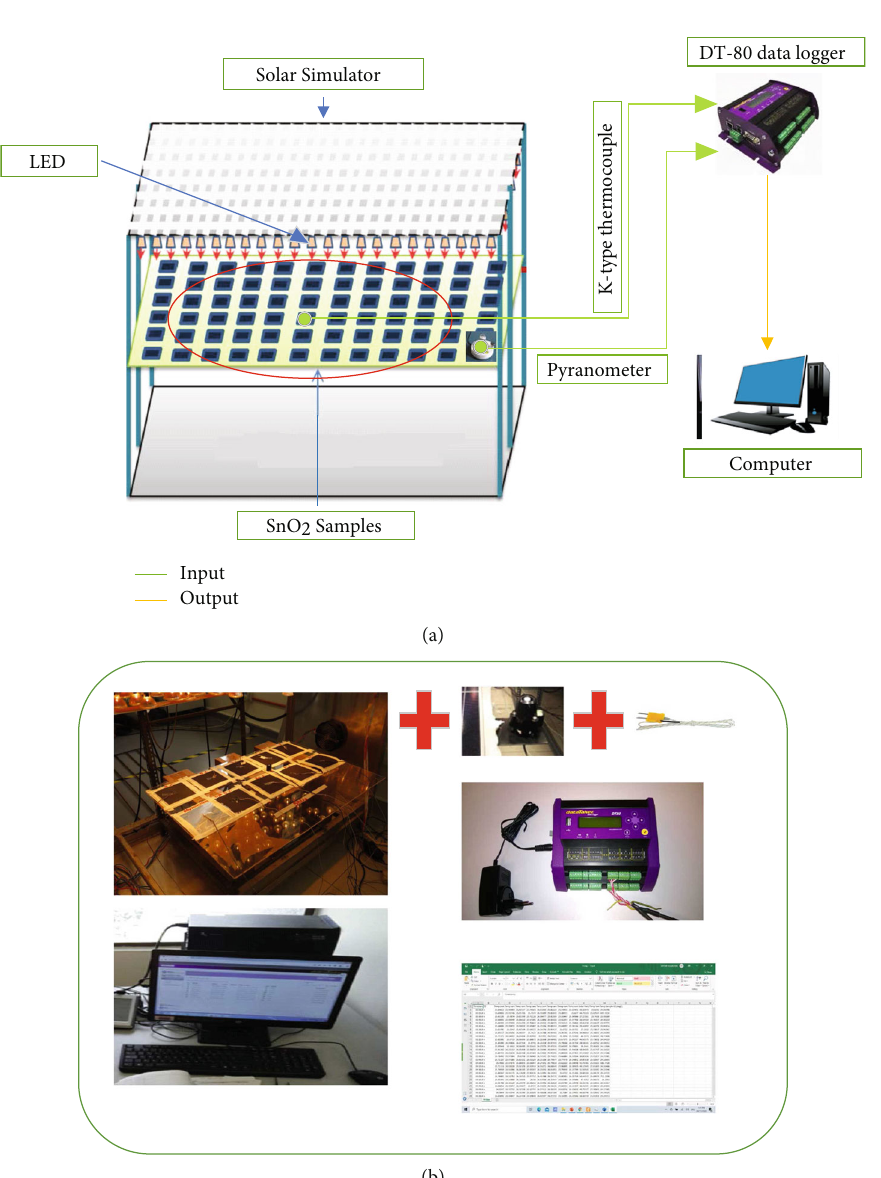
Figure 2: (a) Schematic of Indoor experimental setup and (b) actual Indoor experimental setup.